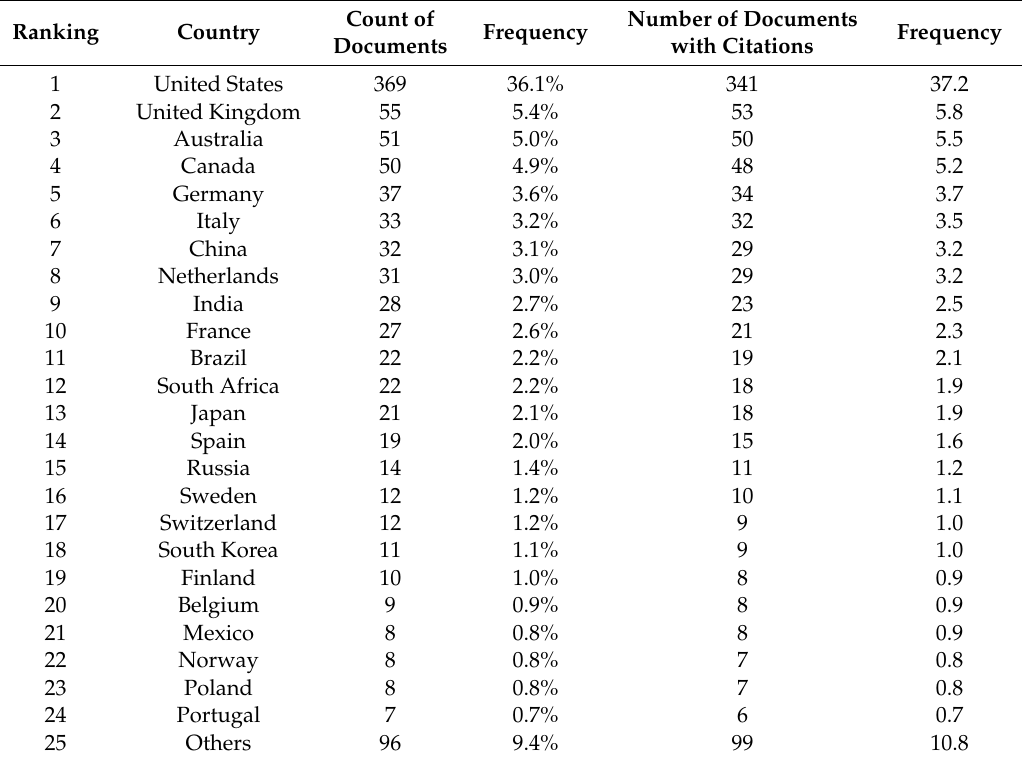
Table 2. Number of papers and citations per country from the data.